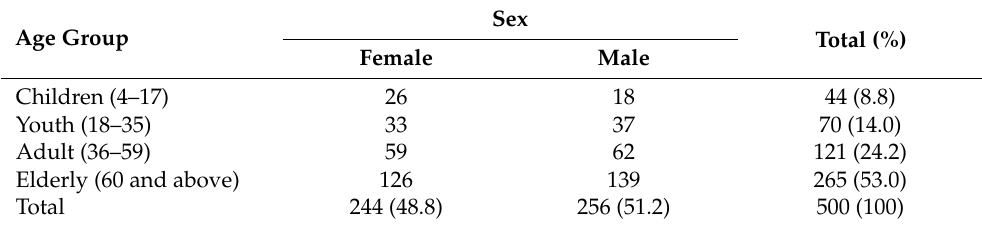
Table 1. Distribution of Age group according to